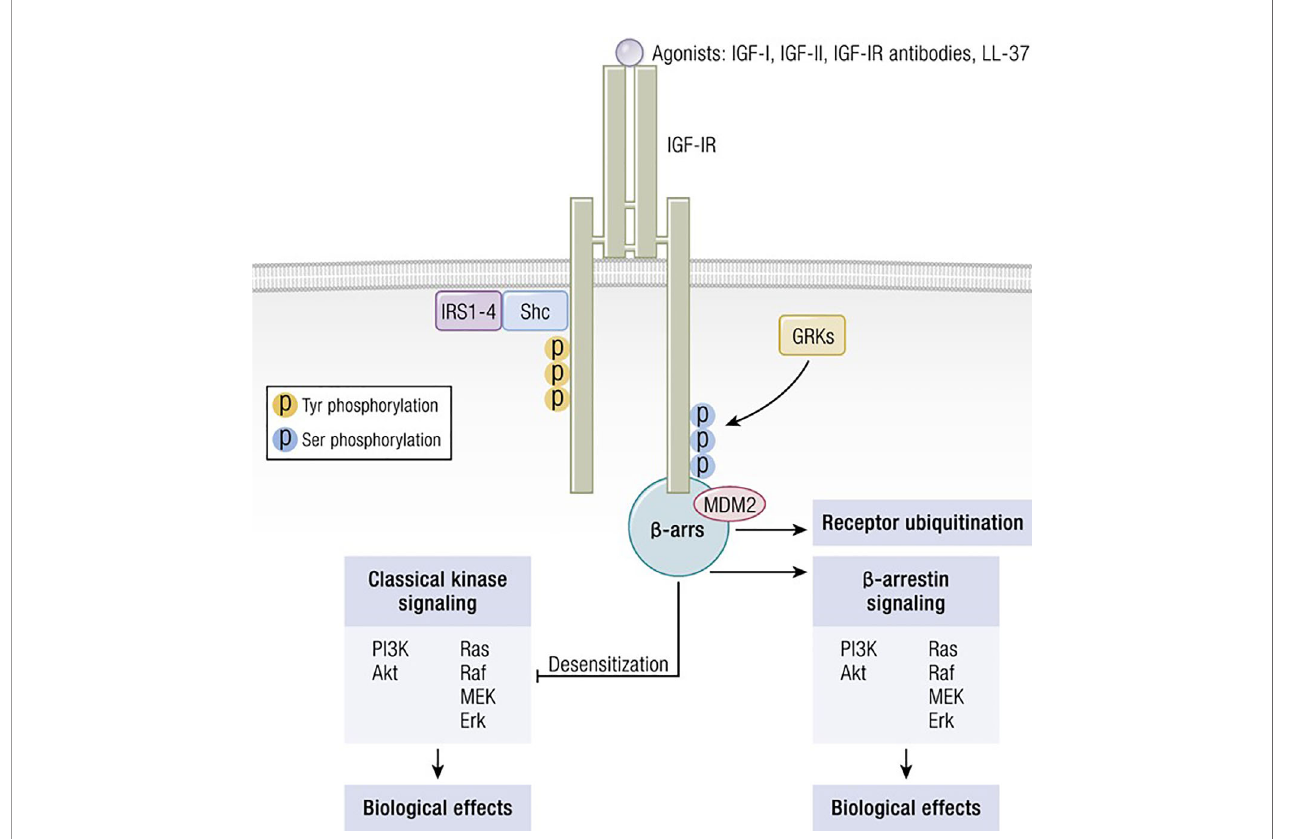
FIGURE 3 | IGF-IR can form functional RTK/GPCR hybrids, thus aggregating tyrosine kinase and GPCR signaling. Ligand-dependent activation of classical kinase- dependent signaling with b -arrestin recruitment provokes GRK-dependent serine phosphorylation located in the IGF-IR C-domain. b -arrestin activates kinase desensitization and ubiquitination and initiates kinase-independent signaling through MAPK. Adapted from Worrall et al. Novel Mechanisms of Regulation of IGF-1R Action: Functional and Therapeutic Implications. Pediatr Endocrinol Rev. 2013